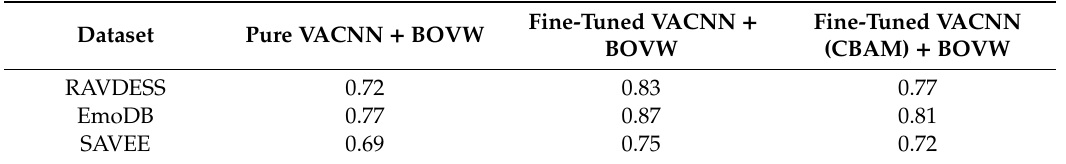
Table 3. Comparison of overall accuracy using the proposed VACNN + BOVW, fine-tuned VACNN + BOVW, and fine-tuned VACNN with CBAM instead VA module +